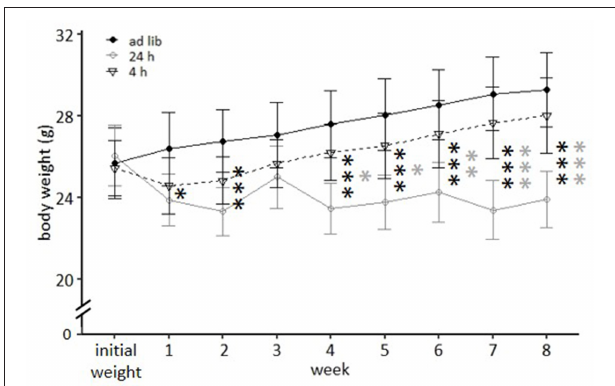
FIGURE 4 | Weight development under different feeding routines over a period of 8 weeks. Initial weight, Ad libitum feeding for all groups, before onset of feeding routines; Ad lib , Ad libitum group; 24h, 24h schedule group; 4h, 4h removal group. Data are presented as means ± SD. Statistics: repeated measures ANOVA, post hoc : Bonferroni-Holm corrected; sample size: n = 12 per group; * p < 0.05, ** p < 0.01, *** p < 0.001. Gray asterisks: comparison 24 and 4h, black asterisks: comparison ad lib and 24